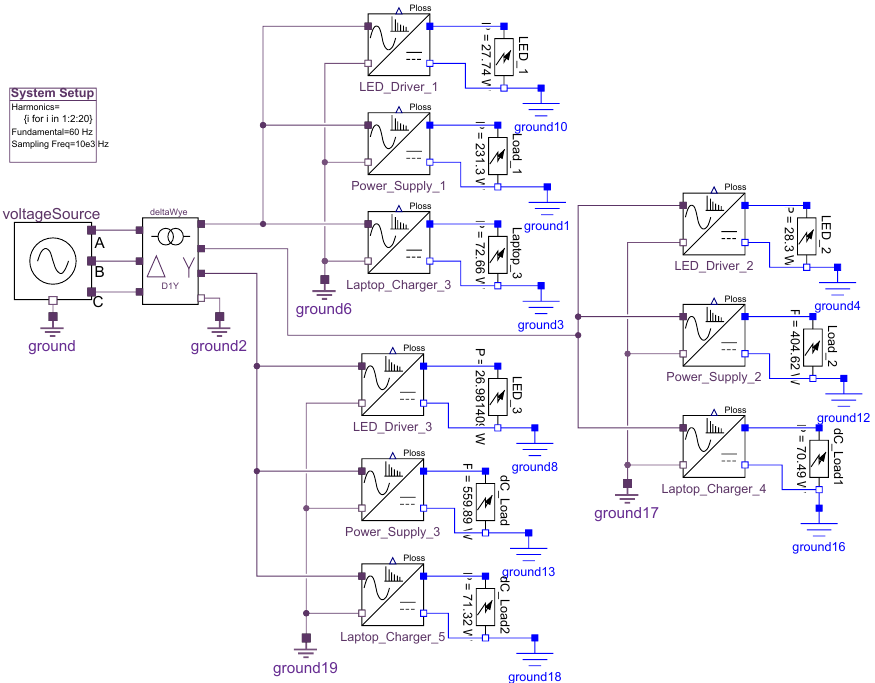
Figure 14. Graphical representation of example electrical network in BEEAM, corresponding to Scenario 2.3 in Section